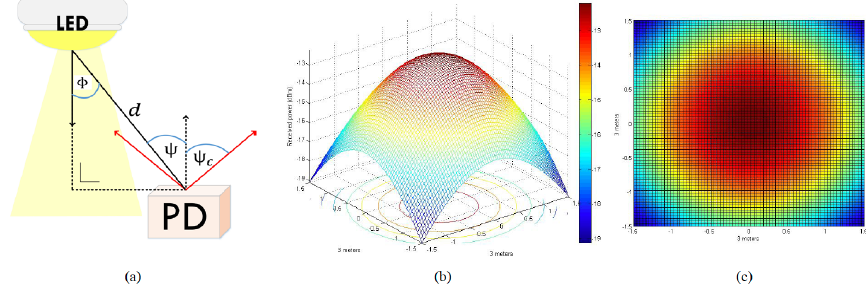
Fig. 3. (a) Geometry LOS channel configuration in indoor VLC system; (b) MATLAB simulation of light intensity distribution in room based 3D view; (c) 2D view with number of grid =